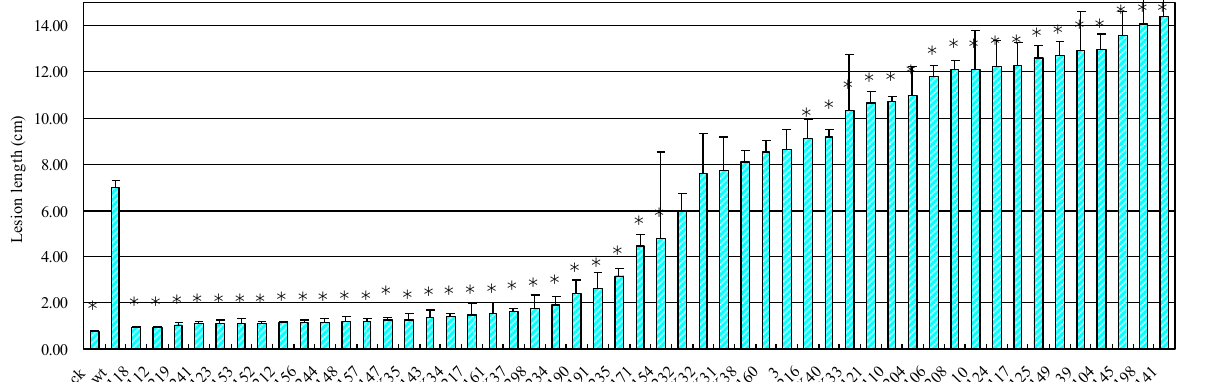
Figure 6. Mean lesion lengths resulting from inoculations of randomly selected Lasiodiplodia theobromae REMI transfor- mants, in a pathogenicity test. Legend: wt: JZB 0300251 strain; ck: non-colonised plugs of PDA; * indicates significant dif - ferences ( P <0.05) between the JZB 0300251 strain and a specific transformant, as determined through Duncan’s method. Standard deviations of the means are